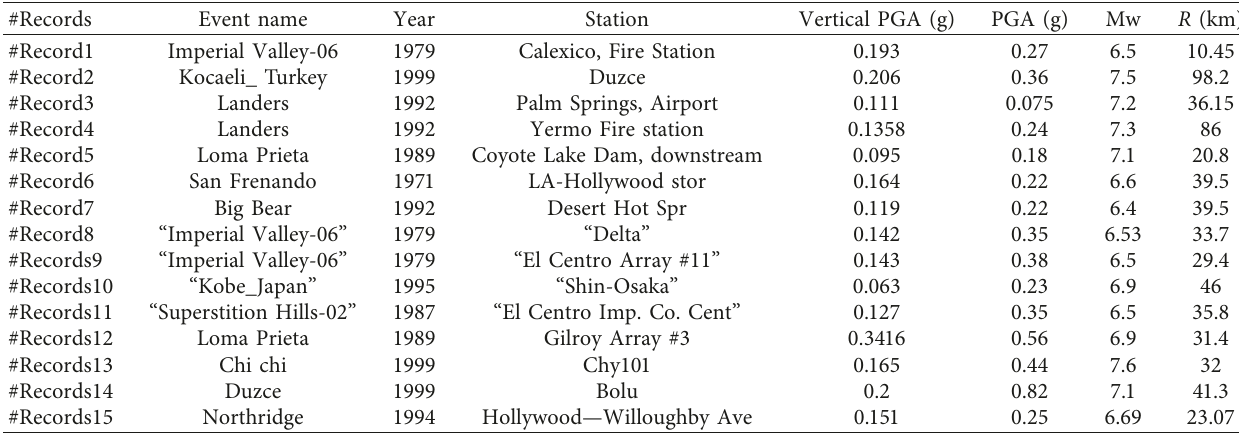
Table 3: Far-field records.